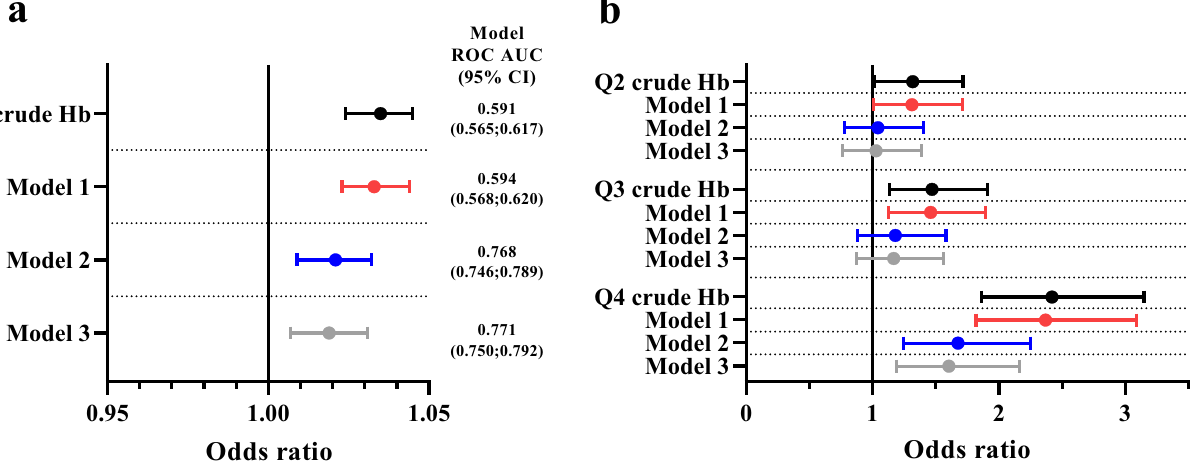
Figure 2. Multivariable logistic regression risk model of gestational diabetes mellitus (GDM). ( a ) Hemoglobin (Hb) as a linear variable in the logistic regression model. Crude Hb = unadjusted model. Model 1 = adjusted for smoking and the gestational week Hb was measured. Model 2 = adjusted for smoking, the gestational week Hb was measured, maternal age, parity, pre-pregnancy body mass index (BMI) and maternal educational attainment. Model 3 = adjusted for smoking, the gestational week Hb was measured, maternal age, parity, pre- pregnancy BMI, maternal educational attainment and hypertensive disorders. ( b ) Hb divided to quartiles and compared with quartile 1 with the lowest Hb level (110–126 g/L) with logistic regression. Q2 = Hb quartile 2 (Hb 127–132 g/L), Q3 = Hb quartile 3 (Hb 133–138 g/L), Q4 = Hb quartile 4 (139–155 g/l). Crude Hb = unadjusted model. Models 1–3 as in ( a ). n = 1816 in ( a ) and ( b ). Model ROC AUC = area under receiver operating characteristic curve of the models. CI confidence